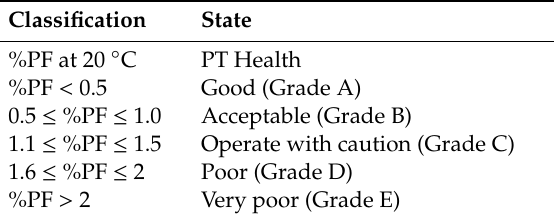
Table A2. PF classifications.